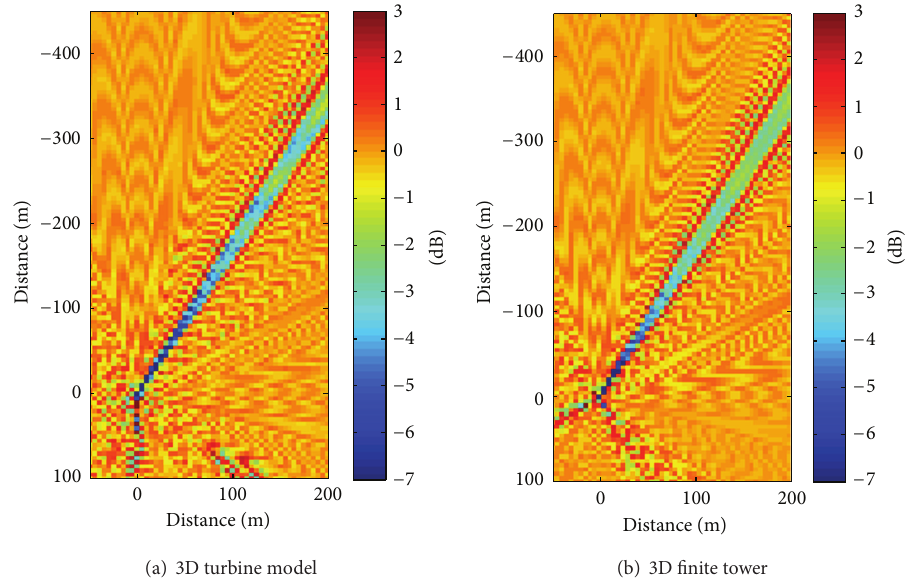
Figure 2: Results of the single-turbine simulation at 500 MHz. (a) Near-field distribution around a 3D turbine model including the tower, nacelle, and blades. (b) Near-field distribution around the cone-shaped tower.